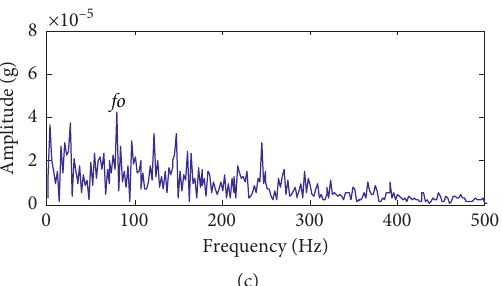
Figure 27: Comparison results of engineering signal by the SK method: (a) the kurtogram; (b) the waveform of filtered signal; (c) the envelope spectrum of filtered